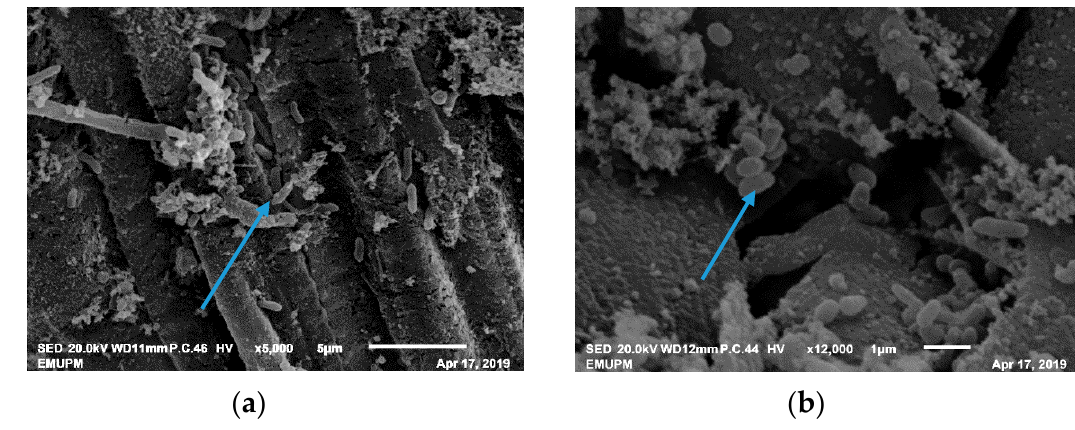
Scheme 2. SEM micrograph showing the colonization of UPMRB9 on roots of a BRRI dhan67 plant. The blue arrow shows UPMRB9 ( a ) in between cell walls and ( b ) near the crevices under saline conditions.